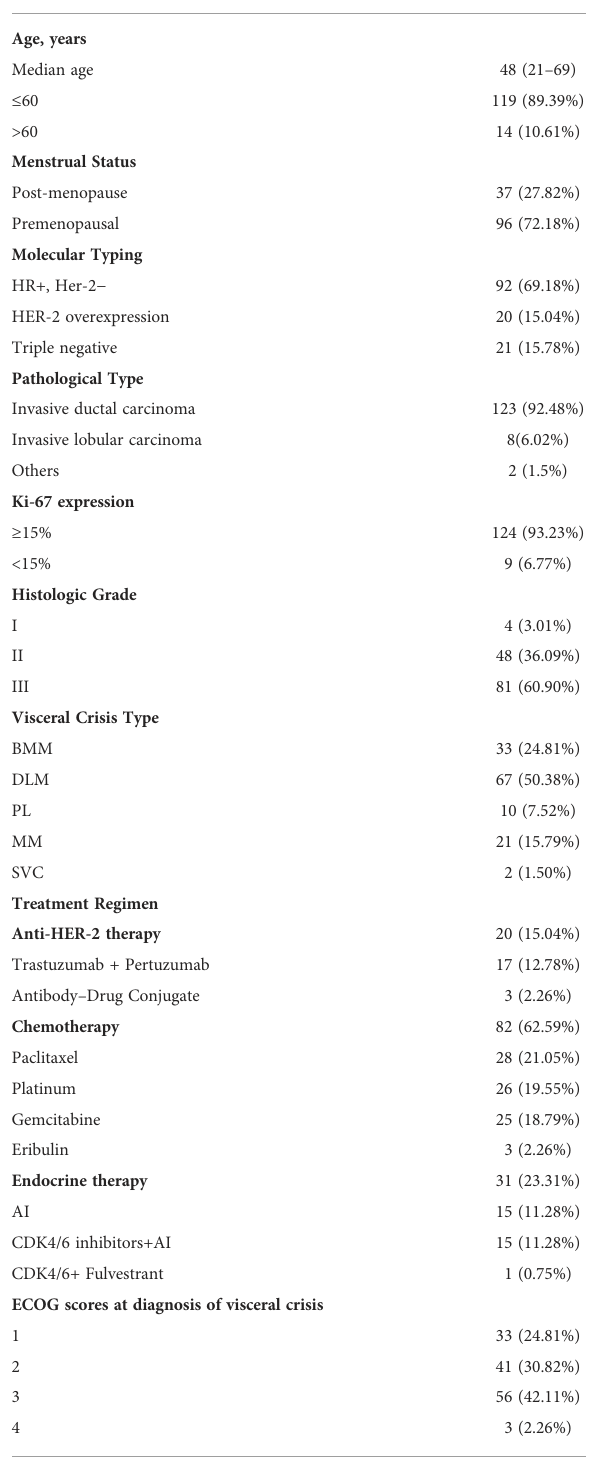
TABLE 1 Clinical characteristics of all patients ( N =